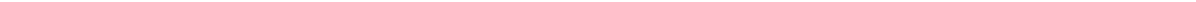
Fig. 4 Identi fi cation of Otp as a direct target gene of Dlx1/2. a Location of Dlx1 ChIPseq peaks in the genome. b , c De novo motif analyses revealed that binding sites for two transcription factors, NHLH1 and Dlx1/2, are enriched in our Dlx1 ChIPseq peaks ( b ), which are mostly located in the summit area